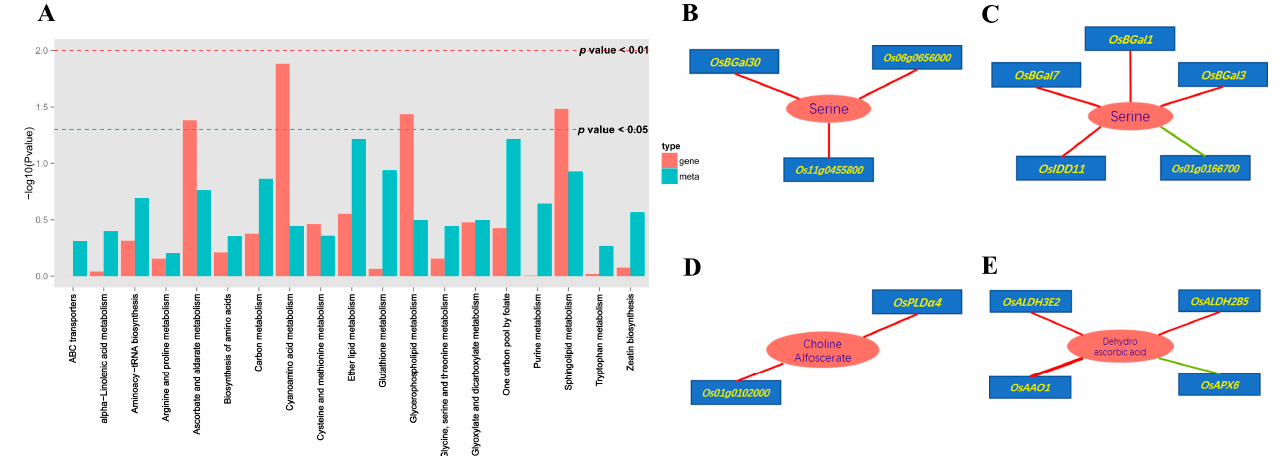
Figure 5. Correlations between the transcriptome and metabolome data. Results of a KEGG co-enrichment analysis of the differentially expressed genes and differentially abundant metabolites in the C18 seedlings revealed by the comparison between the salt + allantoin treatment and the salt stress treatment ( A ). Green and red lines indicate the selected genes and metabolic pathways at p < 0.05 and p < 0.01, respectively. Cyanoamino acid metabolism ( B ). Sphingolipid metabolism ( C ). Glycerophospholipid metabolism ( D ). Ascorbate and aldarate metabolism ( E ). The circles represent metabolites, the boxes represent genes, and the lines represent correlations (positive and negative correlations are in red and green, respectively).